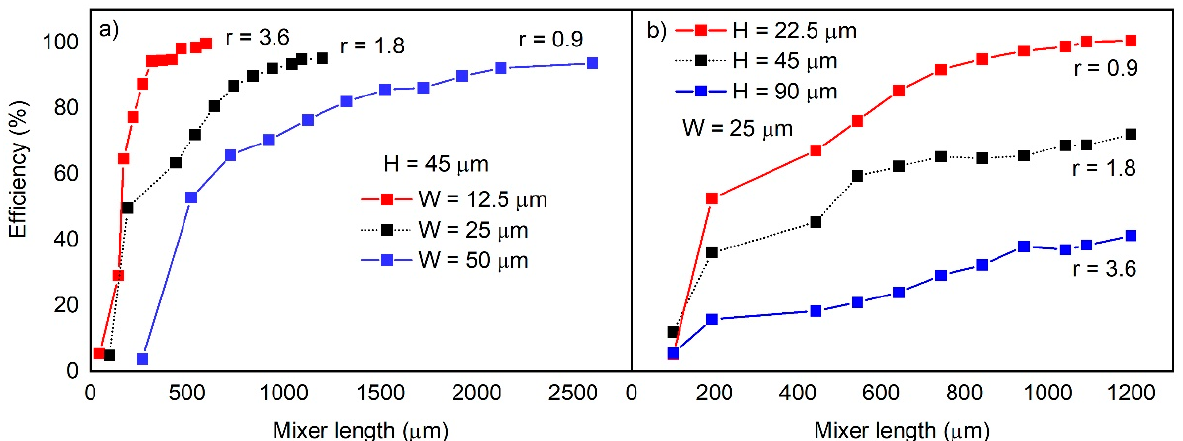
Figure 7. Mixing efficiencies along the length of the serpentine micromixer for ( a ) H = 45 µ m, W = 12.5, 25 and 50 µ m, and ( b ) W = 25 µ m, H = 22.5, 45, and 90 µ m at a flow rate of 100 µ L/min. The aspect ratios are r = 0.9, 1.8, and 3.6. The simulated results matching the height-to-width ratio used experimentally (represented in ( a ) and ( b ) by a dotted line) has an aspect ratio of r = H/W = 1.8 and is included for comparison.